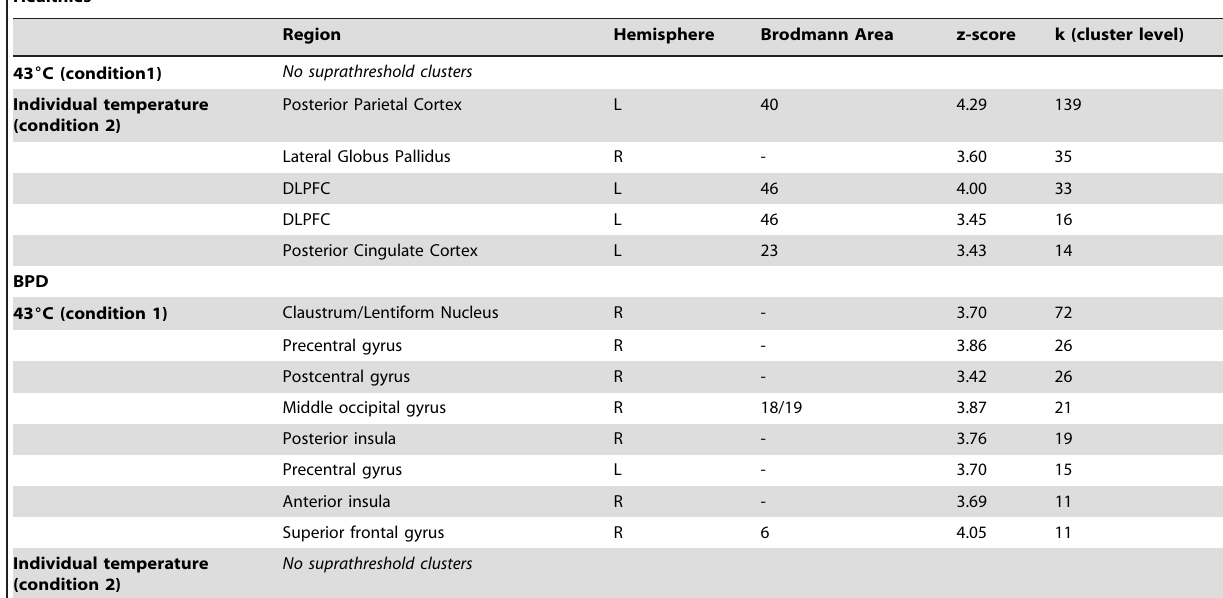
Table 1. Group-specific regression analyses.